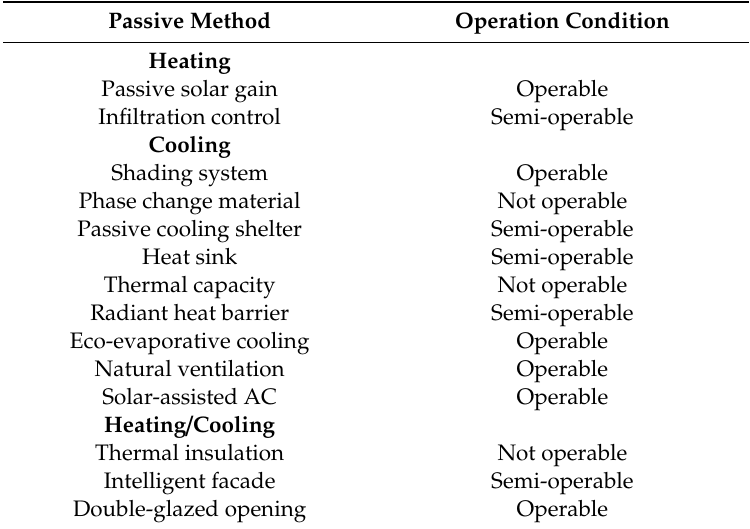
Table 3. Classification of the passive cooling and heating methods by time between